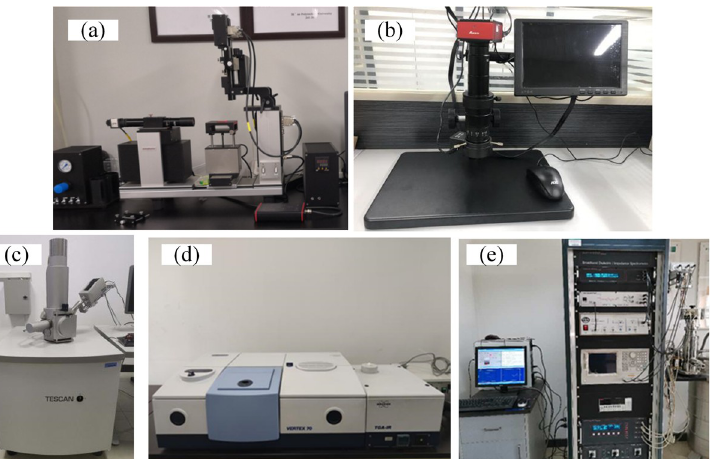
Fig 3. Experimental test instruments. (a) The OCA40Micro static contact angle measuring instrument; (b) The 10A series video microscope. (c) SEM-EDS. (d) The Vertex70 infrared spectrometer. (e) Broadband dielectric spectroscopy impedance meter.